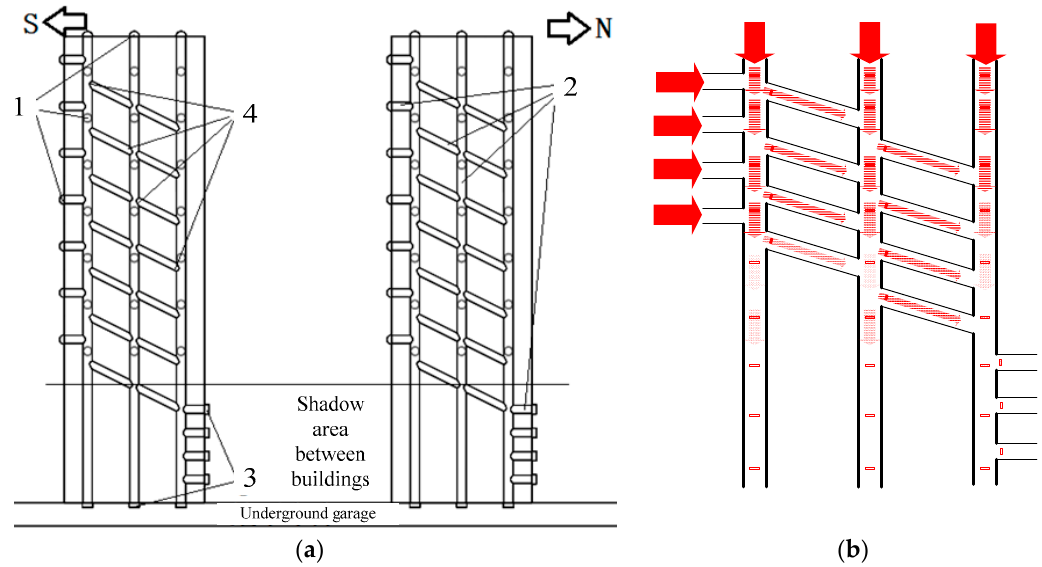
Figure 1. Schematic of the designed solar optical guide lighting (SOGL) system: ( a ) system vertical section view and ( b ) sunlight transfer inside the optical guide pipes. 1. Lighting cover, 2. Optical guide pipe, 3. Diffuser, 4. Node-dimming device